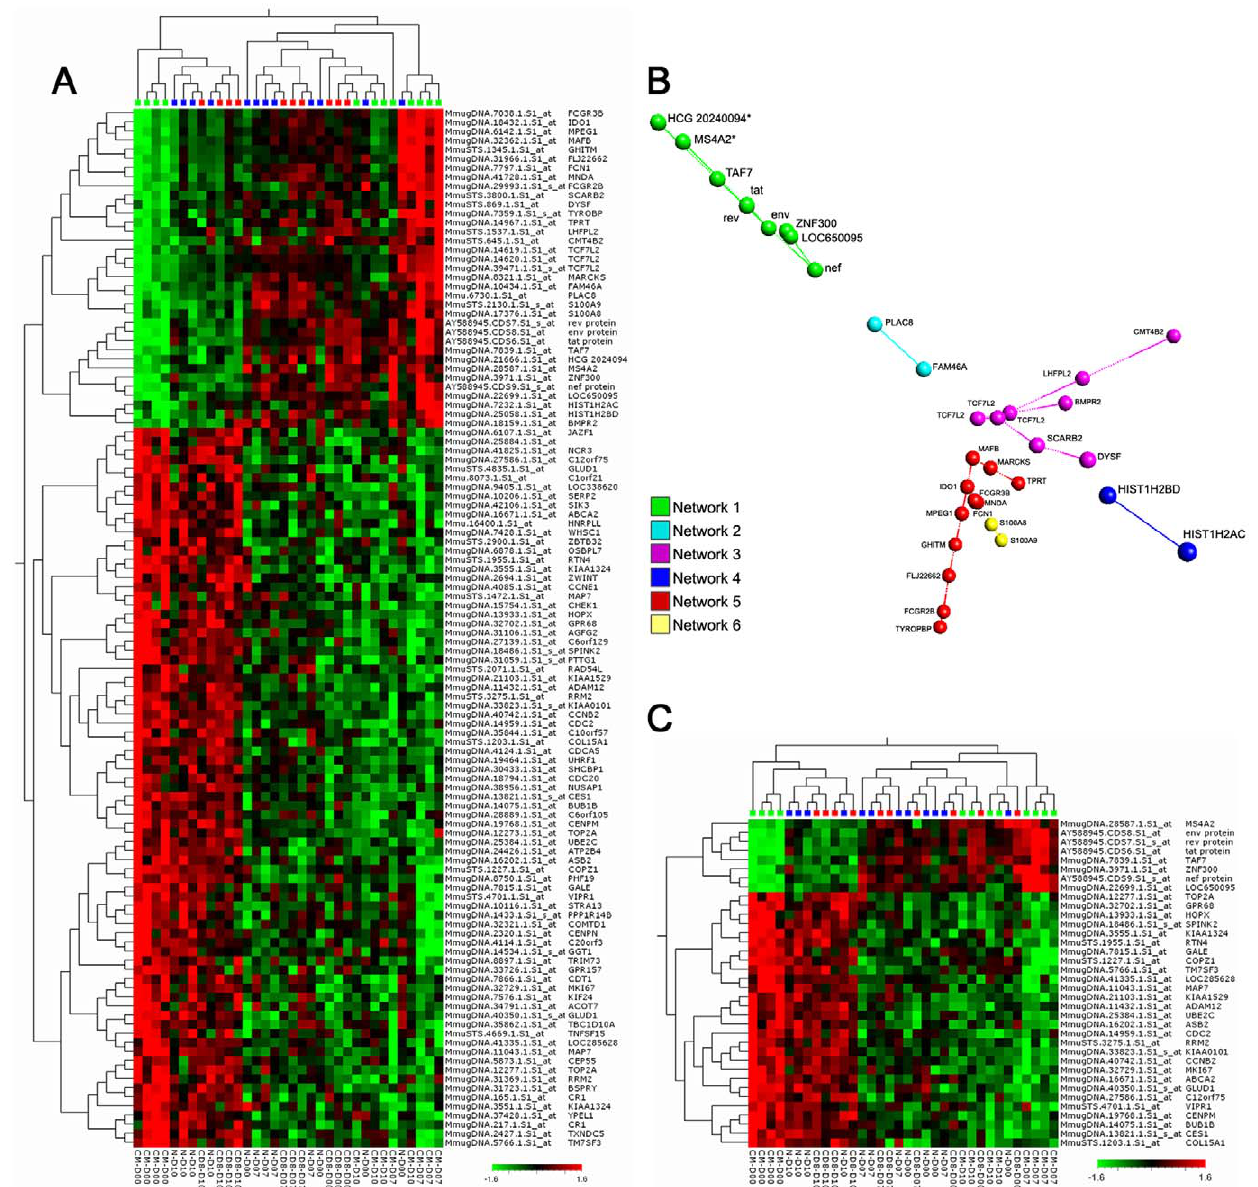
Figure 4. Targeted changes affecting the CD4 + central memory cells. A. Heat map representation of a total set of 113 up and down regulated changes returned by the robust F-test (FDR , 0.05). 35 genes are upregulated and 78 genes are downregulated. B. Isomap representation of PCA 1, 2 and 3 of upregulated targeted changes returned by the F-test (FDR , 0.05) illustrating how sets of genes forms distinct biologic networks. C. Representation of the more stringent F-test (FDR , 0.01) showing a set of 36 up and down regulated genes (8 and 28 respectively). The heat map representations display data normalized to a mean of 0. Hierarchical clustering was performed on the smallest maximum pair wise distance (maximum